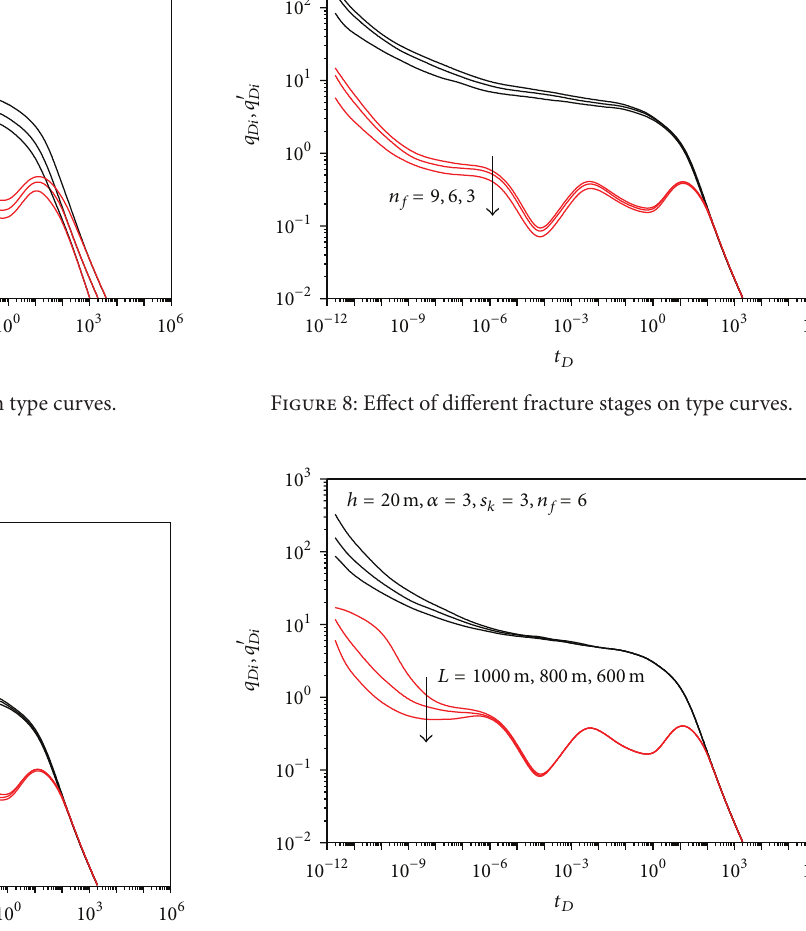
Figure 9: Effect of horizontal well lateral length on type